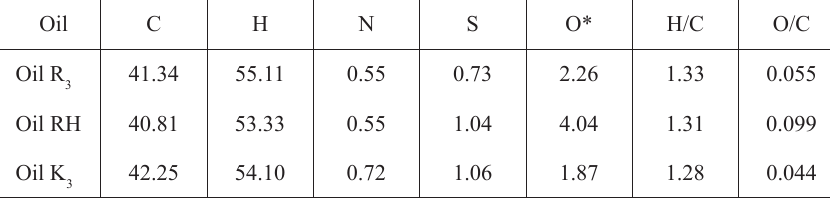
Table 4. Elemental analyses of the oils, atomic %